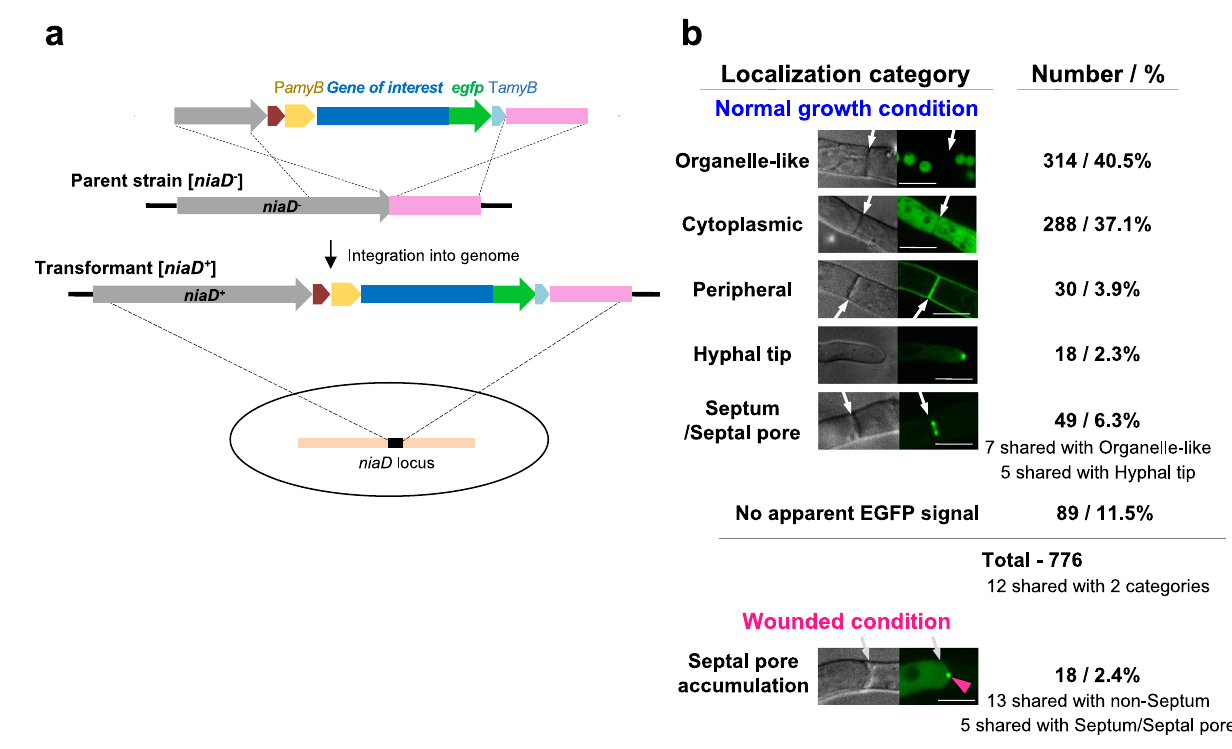
Fig.2|Subcellularlocalizationofcandidateseptalporeproteins.a Schematicof theexpressioncassetteforEGFPfusionsofselectedproteinstobeinsertedinthe A. oryzae genome. b Subcellular localizations of the 776 proteins. Representative